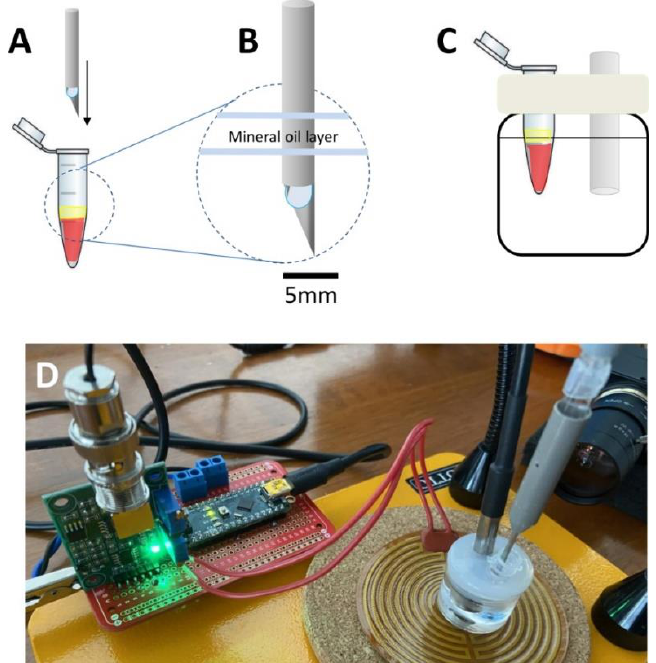
Figure 1. Experimental setup. ( A ) A micro pH electrode is inserted into the loop-mediated isother- mal amplification (LAMP) colorimetric reaction mix and ( B ) a thin layer of oil is added to avoid evaporation during incubation ( C ) in an oil bath. ( D ) Image of the actual system; a heating mat connected to an Arduino-based proportional–integral–derivative (PID) controller is used to control the temperature at 62.5 ± 1.5 ◦ C.